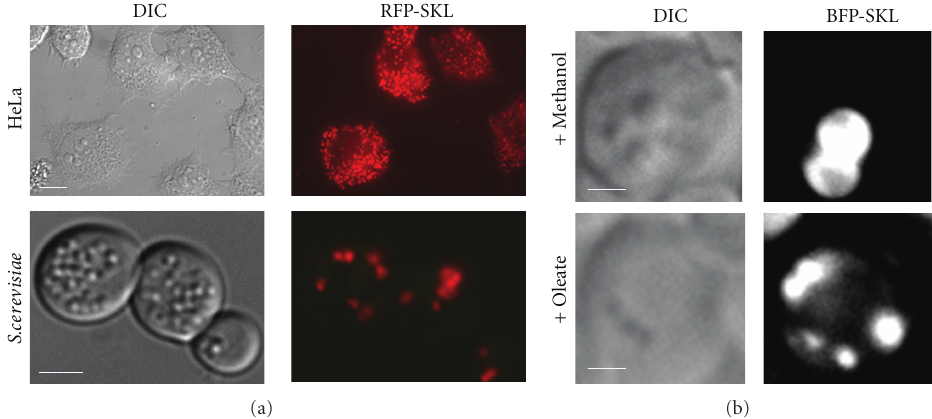
Figure 2: Comparison of peroxisome number and morphology in di ff erent eukaryotic cells and under di ff erent proliferation conditions. (a) Upper panel: Human HeLa cells expressing the peroxisomal marker, RFP-SKL, under basal growth conditions. Lower panel: S. cerevisiae cells expressing RFP-SKL after peroxisome induction in oleate medium. The relative number of peroxisomes per cell di ff ers greatly between di ff erent eukaryotic cell types. Size marker = 2 μ m. (b) Grayscale images of P. pastoris cells expressing BFP-SKL as peroxisomal marker. Upper panel: large, clustered methanol-induced peroxisomes; lower panel: small, unclustered oleate-induced peroxisomes. Note the di ff erence in size and appearance of peroxisomes induced by di ff erent carbon sources. Size marker = 2 μ